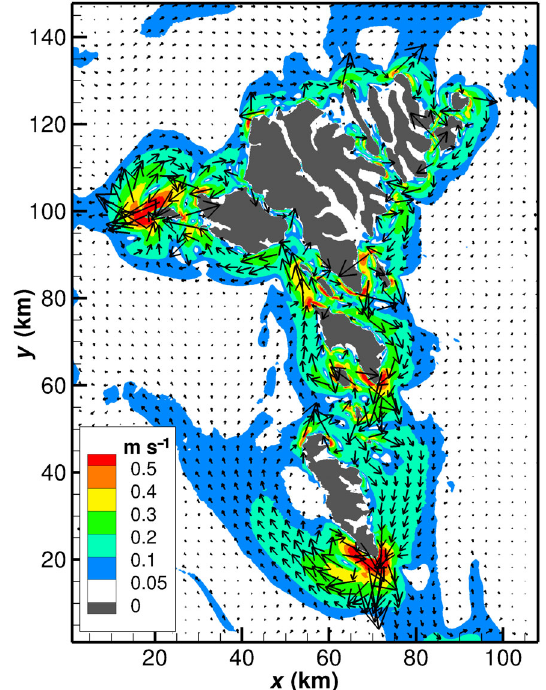
Fig. 2. Residual tidal current velocity around the Faroe Islands. The vectors indicate the direction, and the colors indicate the speed (Simonsen & Niclasen